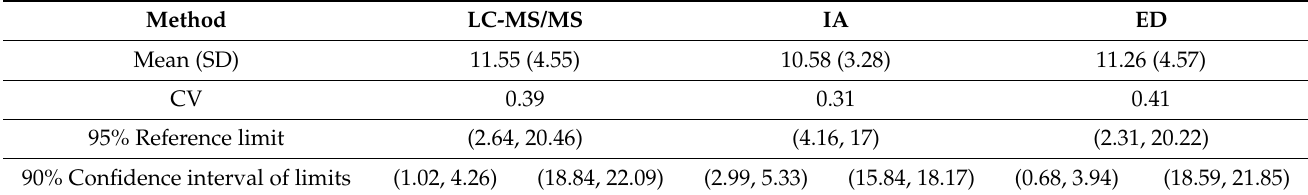
Table 1. Basic statistics of FT4 data (pg/mL) inclusive of outliers ( N = 62) using 3 methods. Method